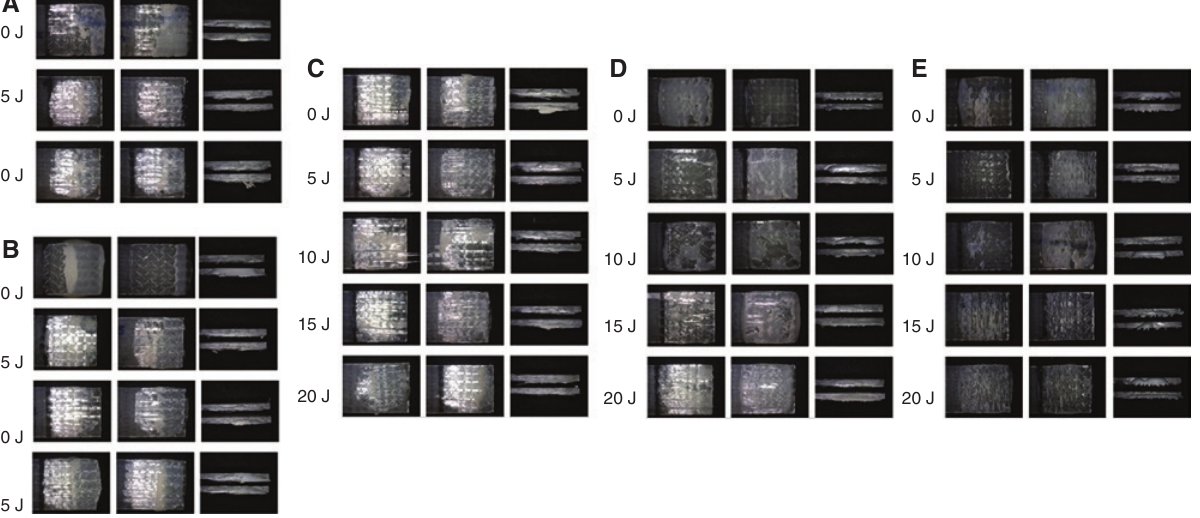
Figure 11: Photos of failed specimens: (A) -20 ° C, (B) 0 ° C, (C) 20 ° C, (D) 40 ° C, and (E) 60 °